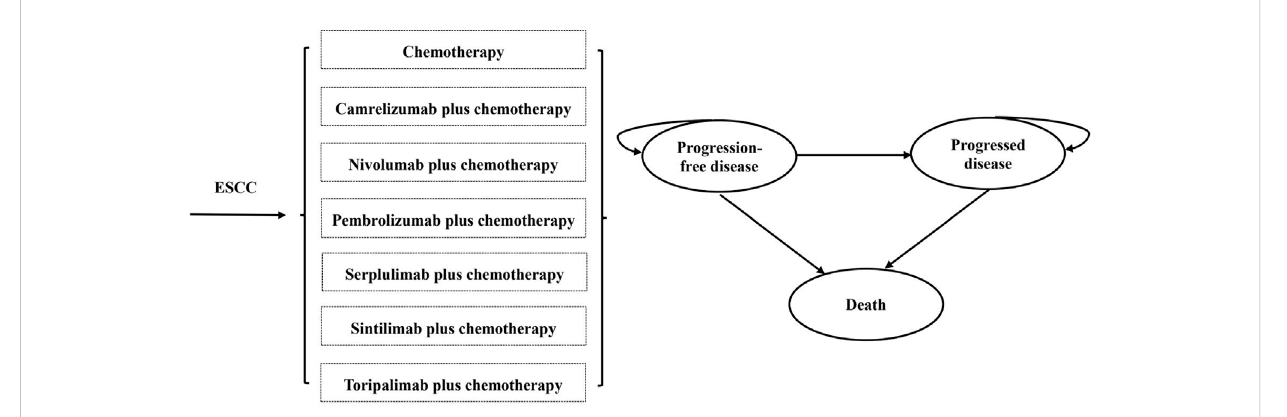
FIGURE 1 The structure of the partitioned survival model. (ESCC, esophageal squamous-cell